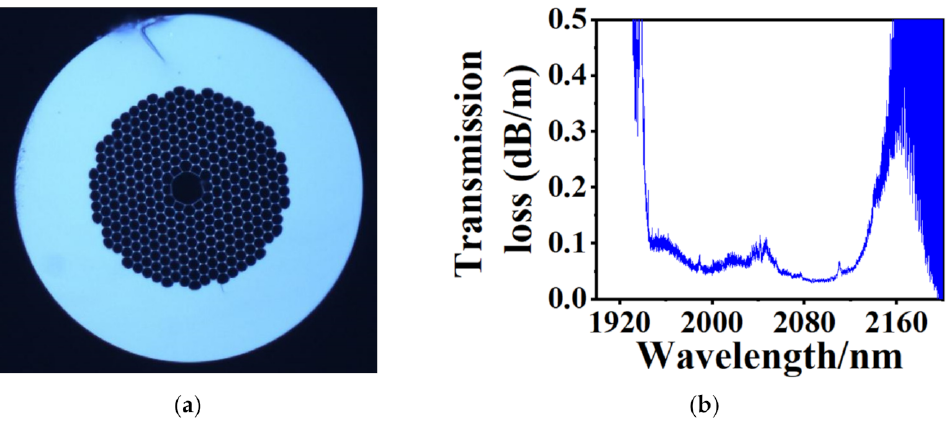
Figure 3. ( a ) Scanning image of the cross section of HCF; ( b ) measured transmission loss of